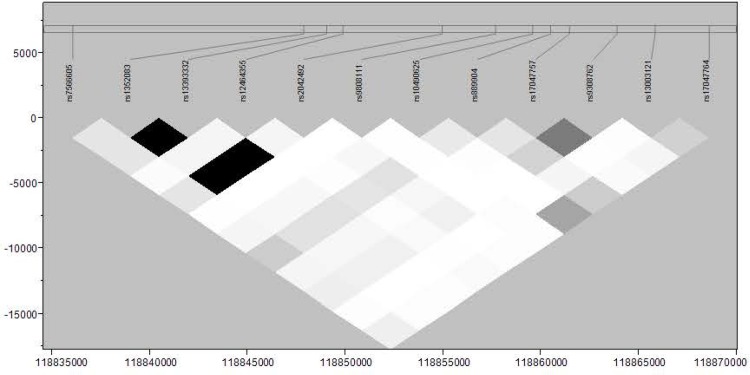
Linkage disequilibrium as measured by r2 across INSIG2 in Non-Hispanic Whites.